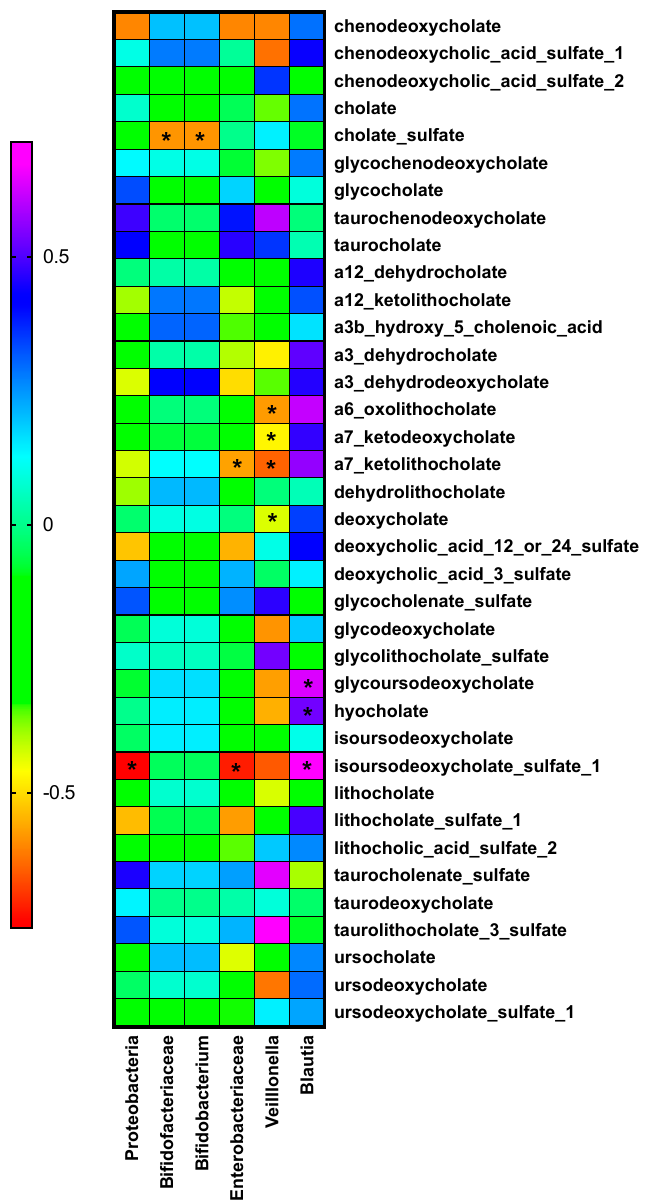
Figure 3. Heatmap of the Spearman correlations between bacteria of interest and secondary bile acids. * Indicates p < 0.05.